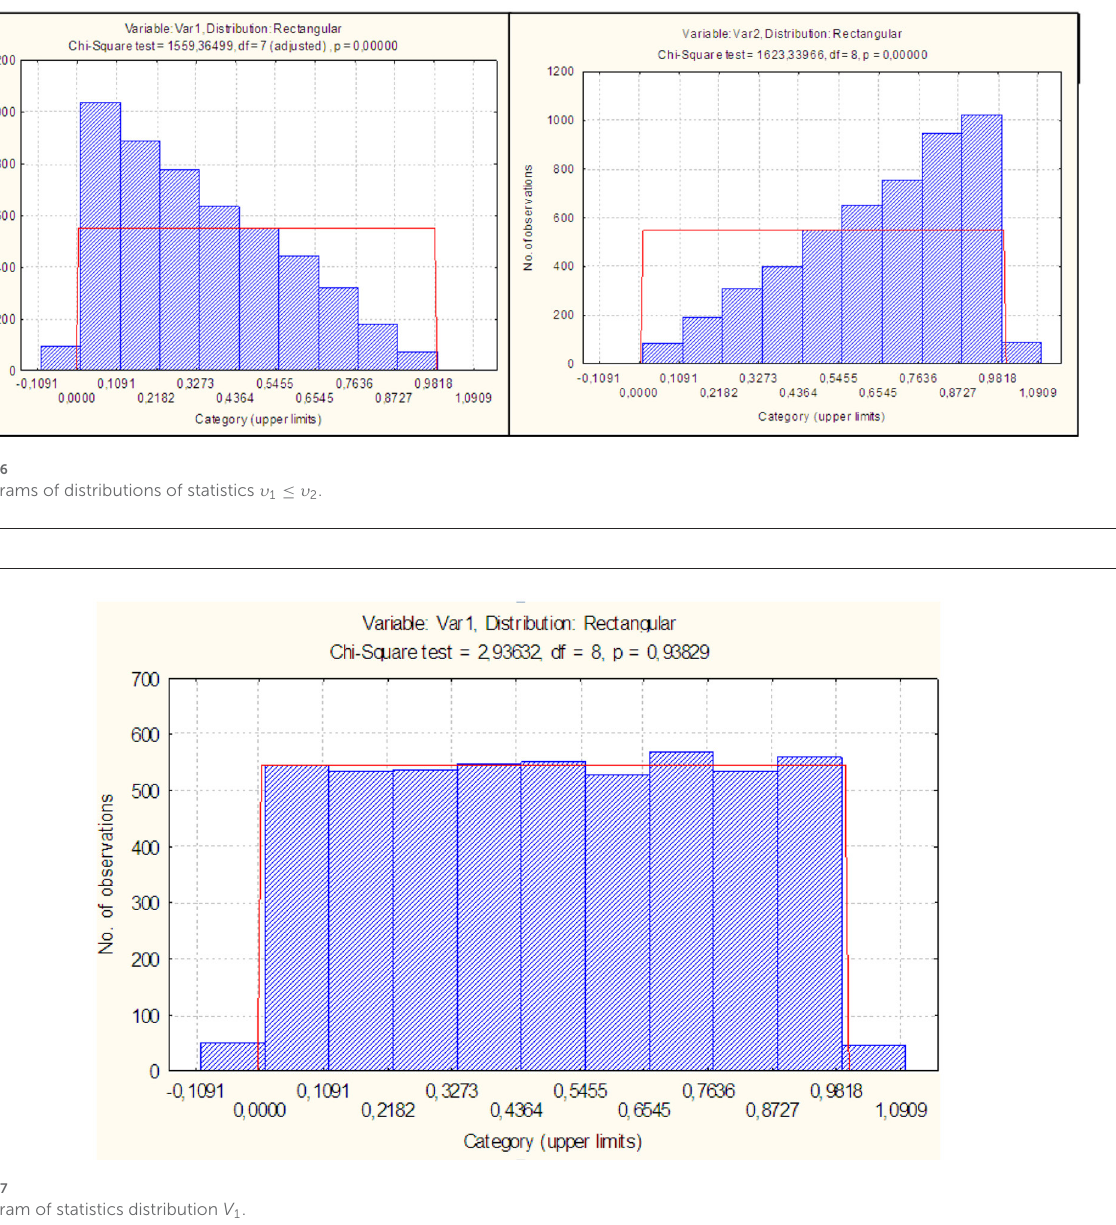
FIGURE7 Histogram of statistics distribution V 1